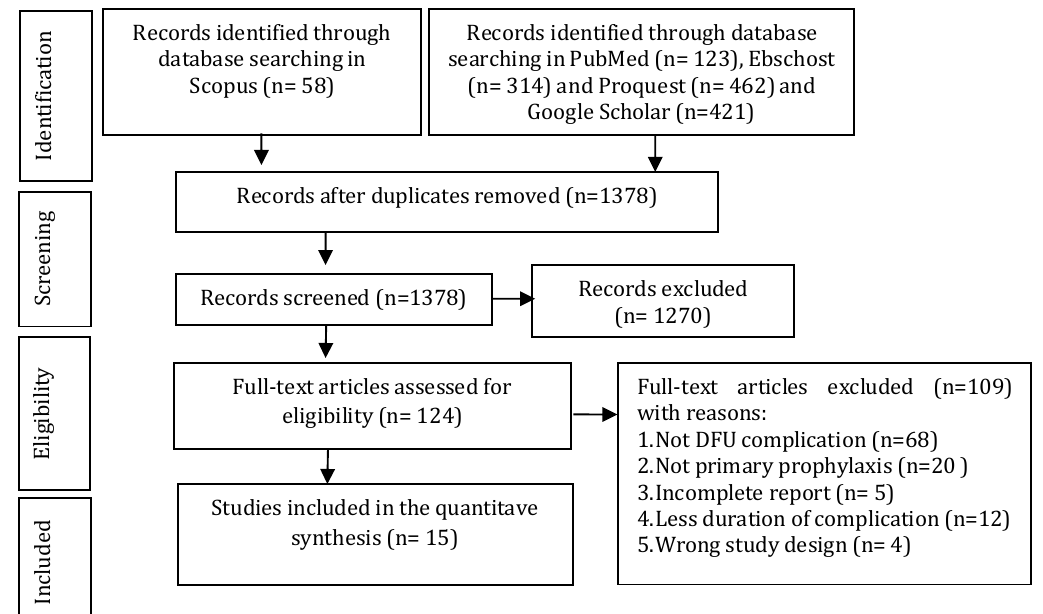
Figure 1. Article Selection